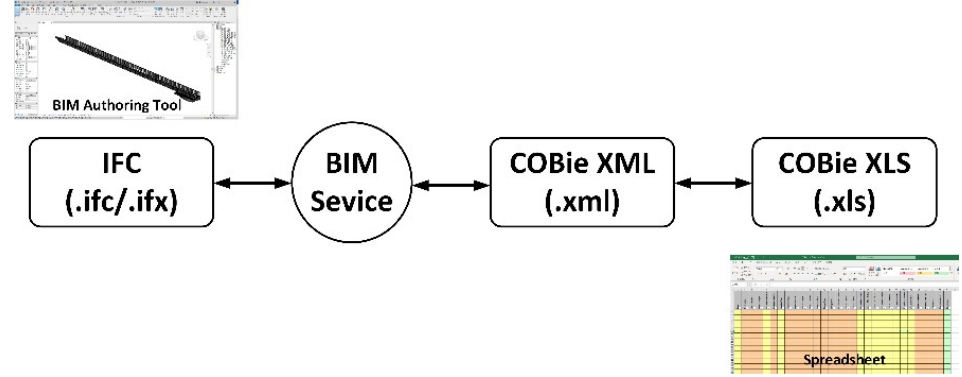
Figure 4. IFC-COBie, data exchange process (Adapted from East Willam, 2007).